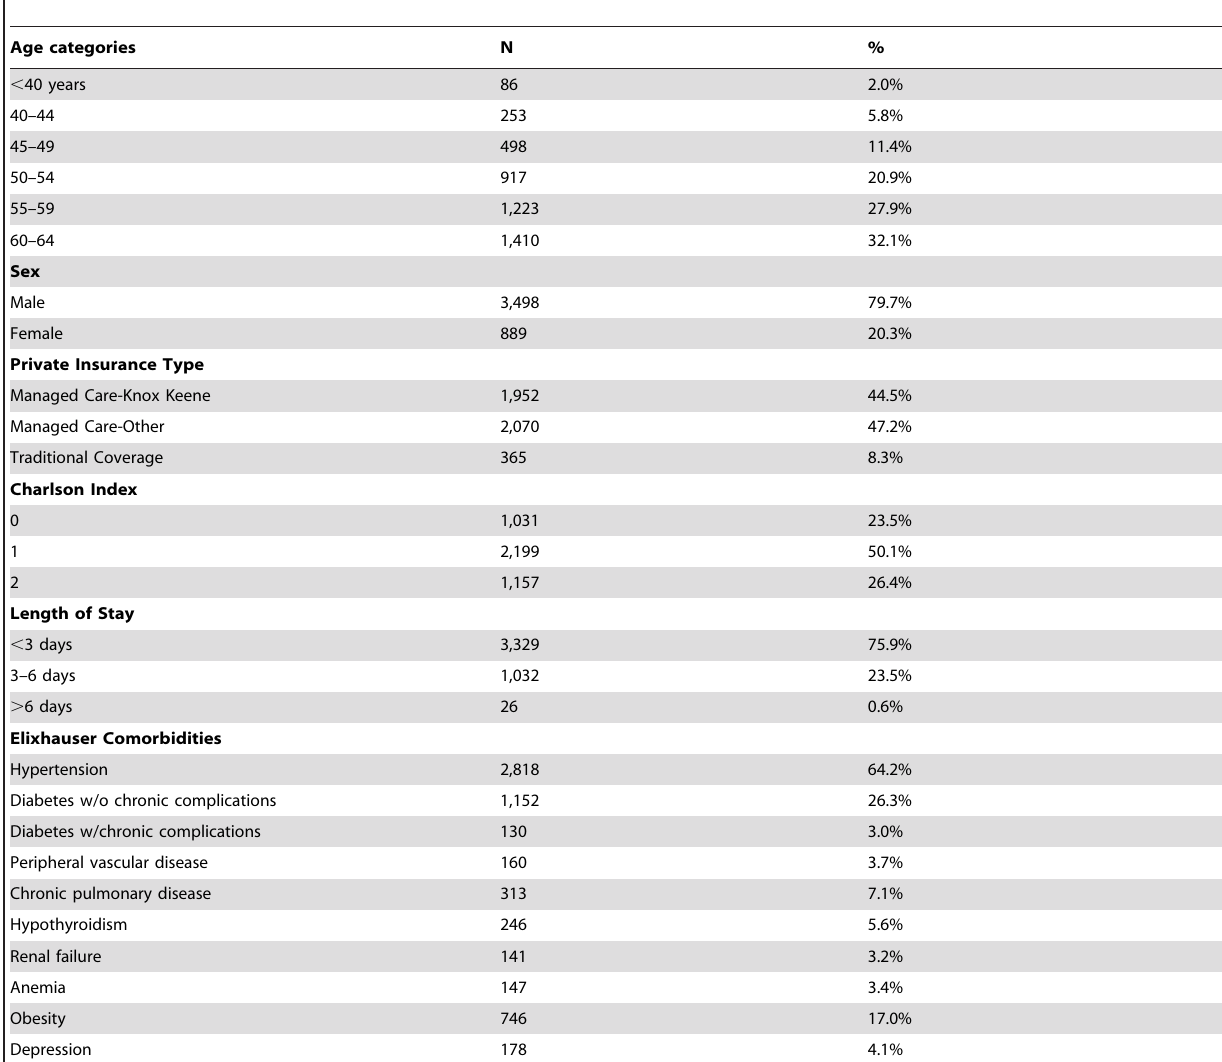
Table 1. Characteristics of patients in the study sample (n=